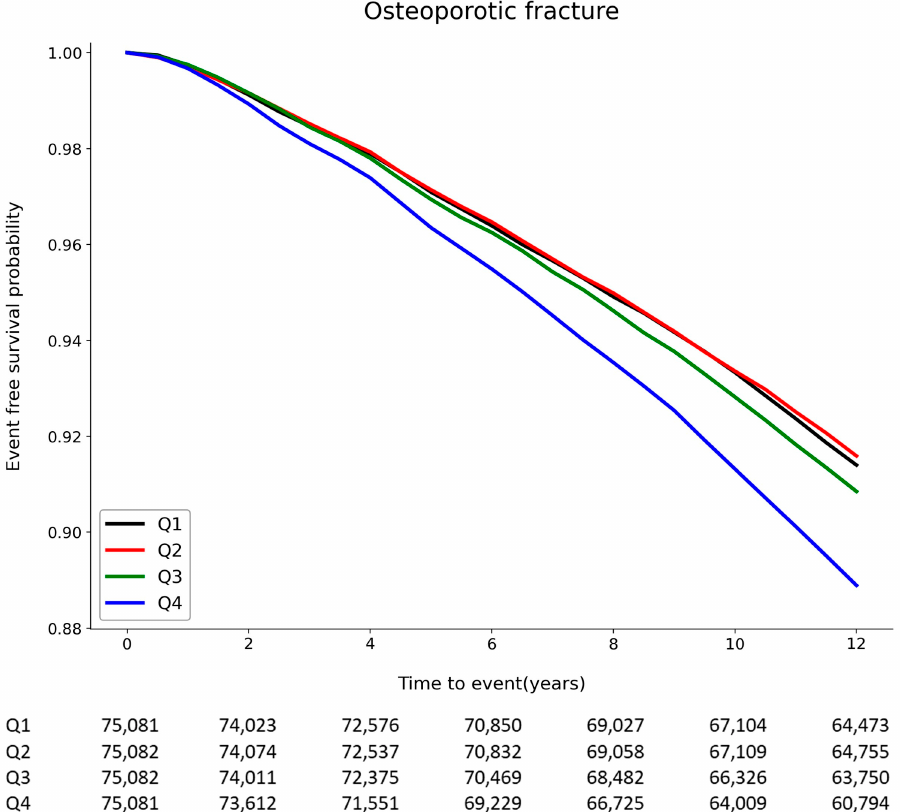
Figure 2. Kaplan–Meier survival curve displaying the estimated fracture-free probability for quartiles of total cholesterol variability.